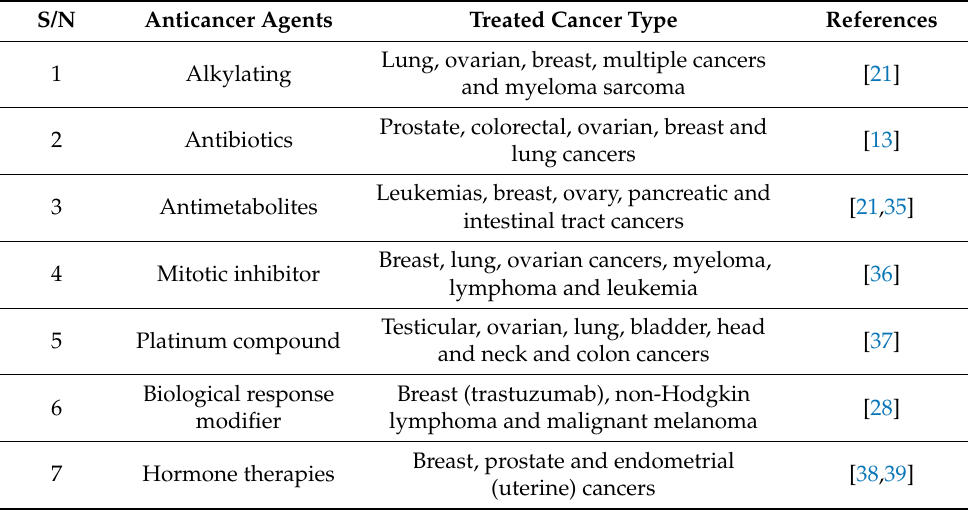
Table 1. Anticancer agents and the cancer types they are used to